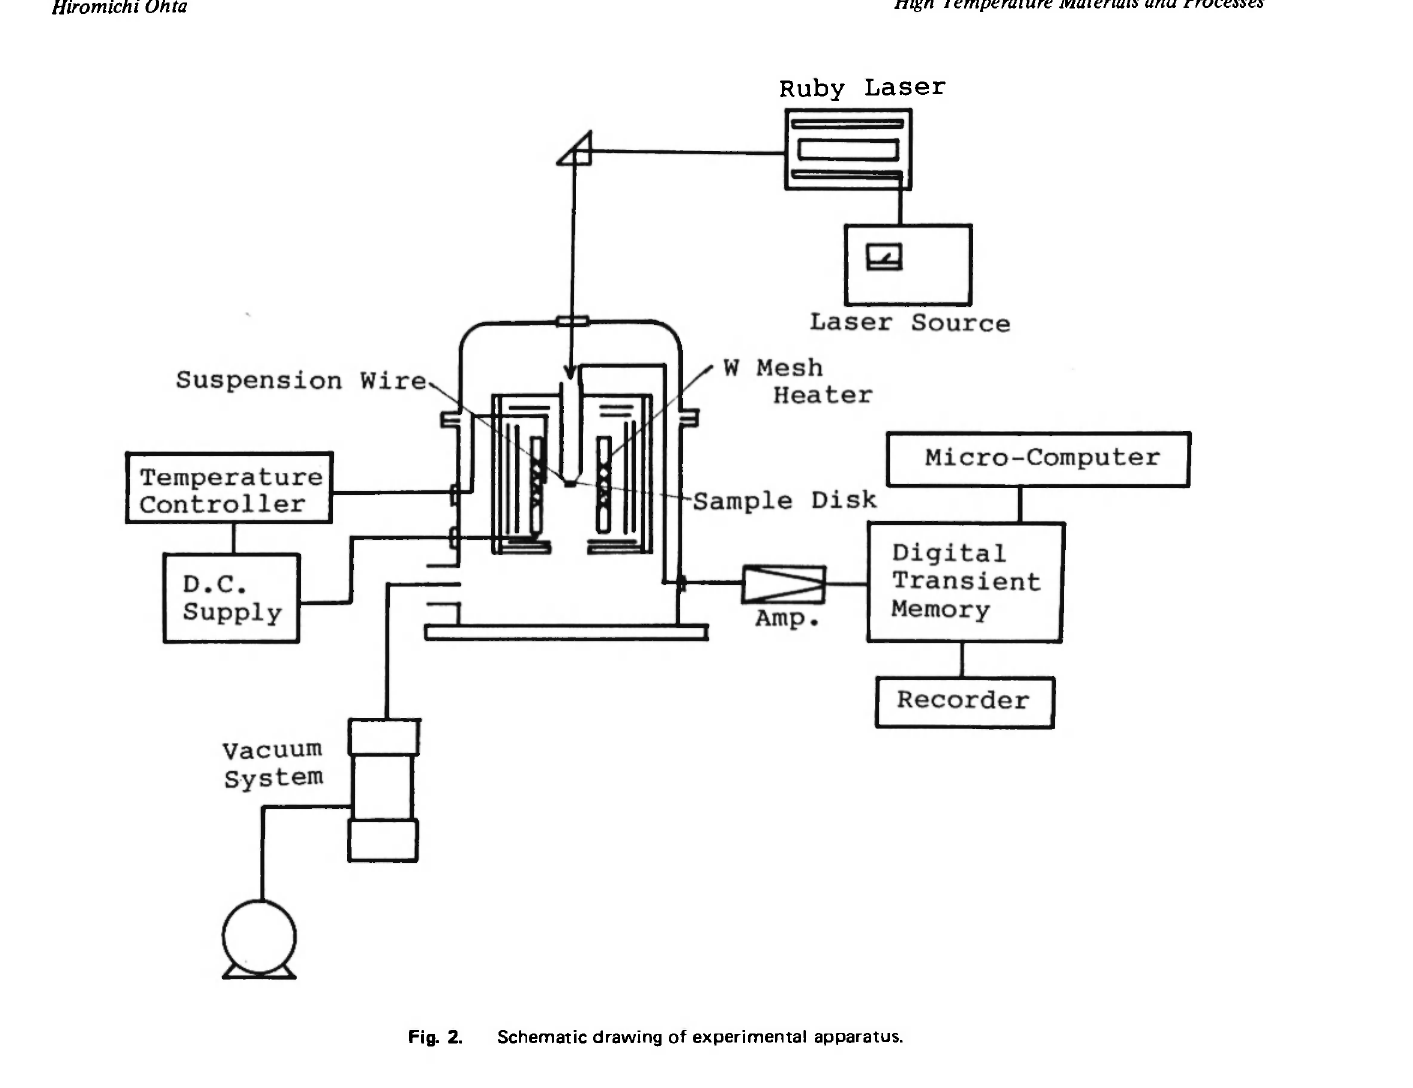
Fig. 2. Schematic drawing of experimental